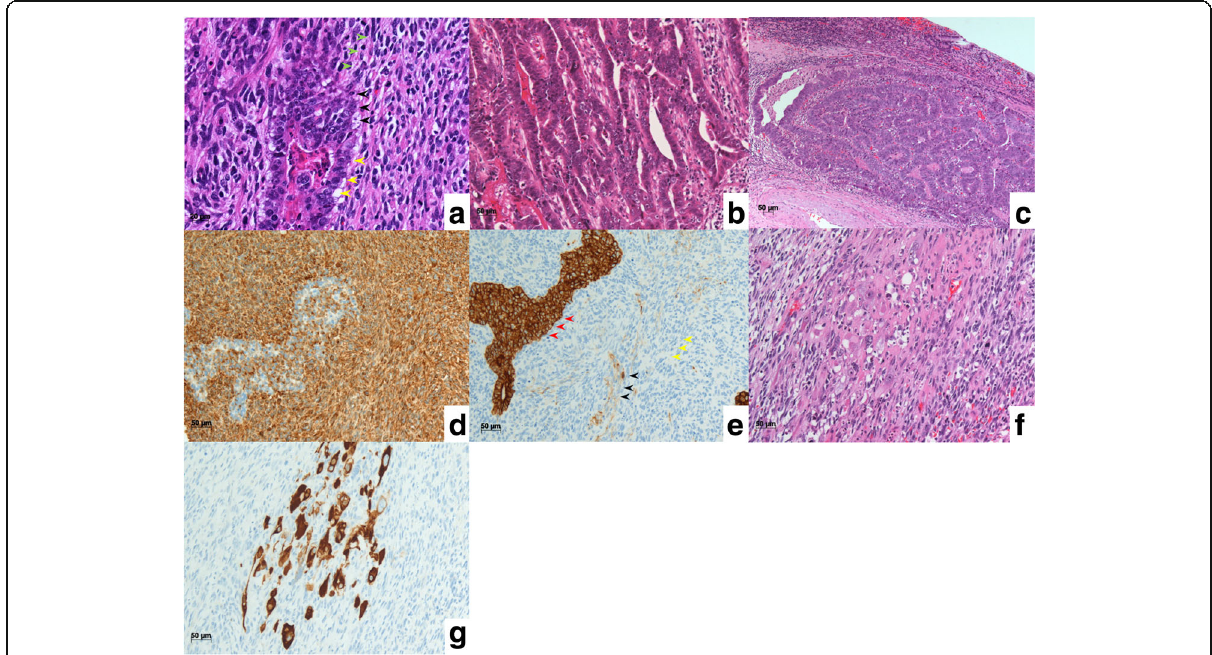
Fig. 4 Histopathological findings. a Transitional zones (black arrowhead) between the carcinomatous (yellow arrowhead) and sarcomatous components (green arrowhead) were observed in the tumor. b The adenocarcinoma component was found in the mucosa of the stomach. c The venous invasion found in the submucosa consisted of adenocarcinoma cells. Immunohistochemical findings. d The tumor was positive for vimentin. e The carcinomatous components (red arrowhead) were positive for cytokeratin CAM5.2 and the sarcomatous components (yellow arrowhead) were partly positive for cytokeratin CAM5.2 (black arrowhead). Histopathological findings of rhabdomyosarcoma. f The tumor contained cells with eosinophil-abundant cytoplasm. g The cells with eosinophil-abundant cytoplasm were positive for